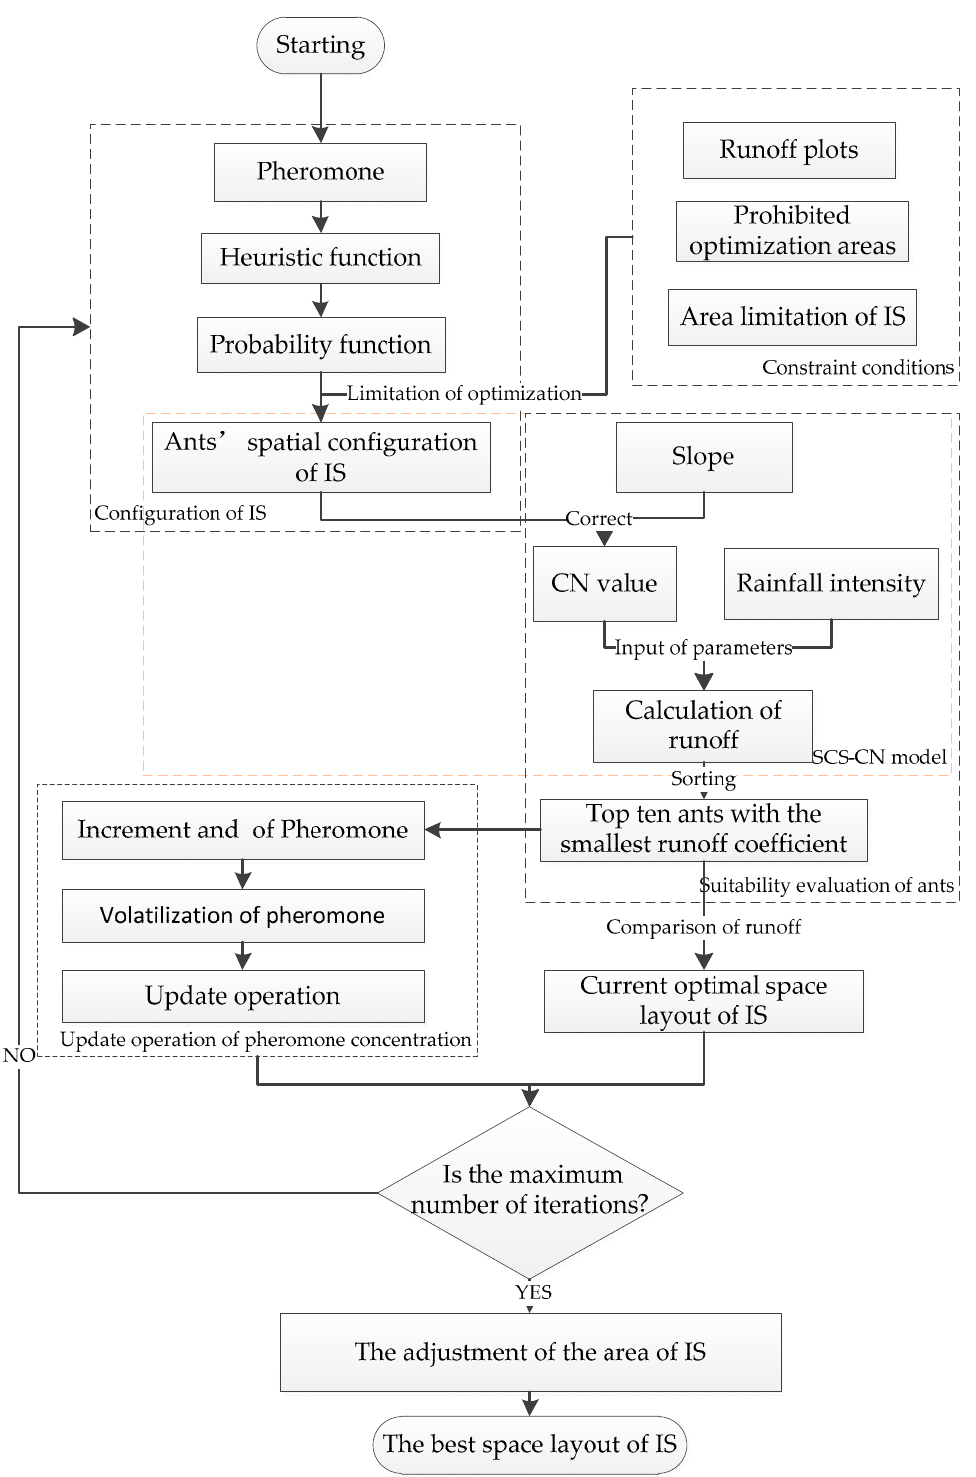
Figure 5. Integration of SCS-CN and ACO. Abbreviation: IS, impervious surfaces.